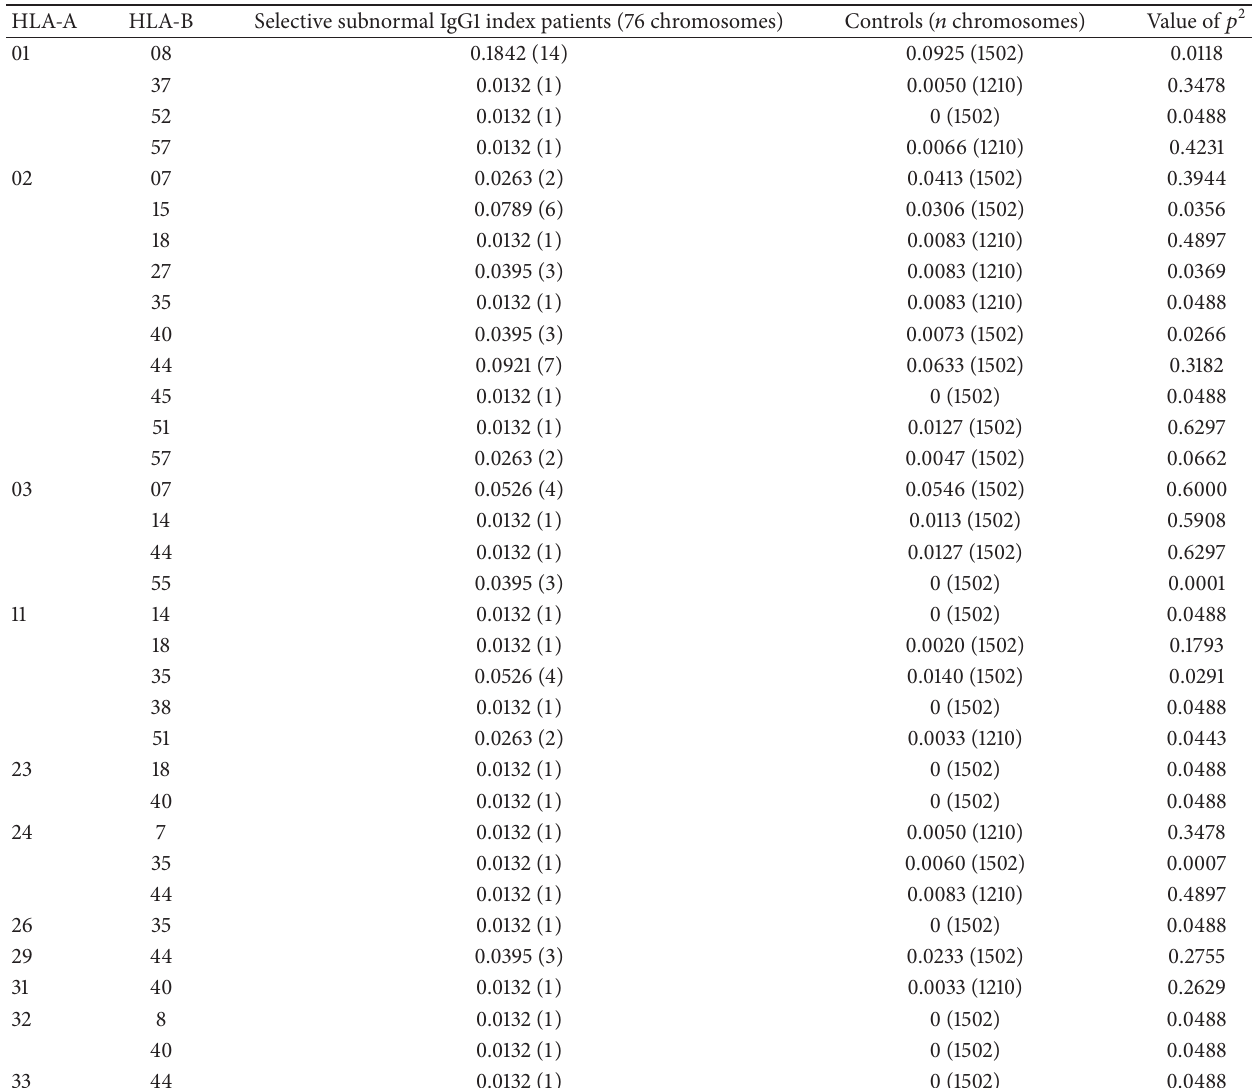
Table 4: HLA haplotype frequencies in Alabama adults 1